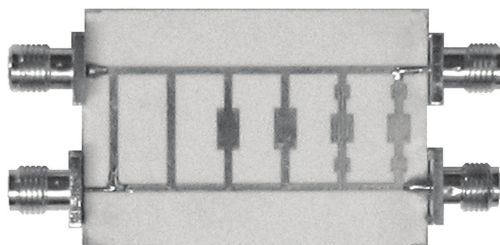
Figure 5: The fabricated profile of the UWB Minkowski branch line